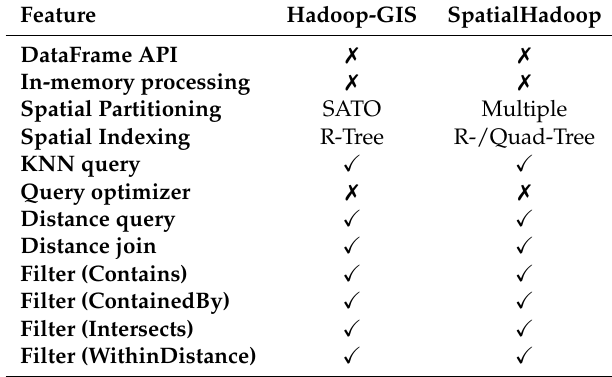
Table 4. Comparison of Hadoop-based spatial big data processing frameworks.